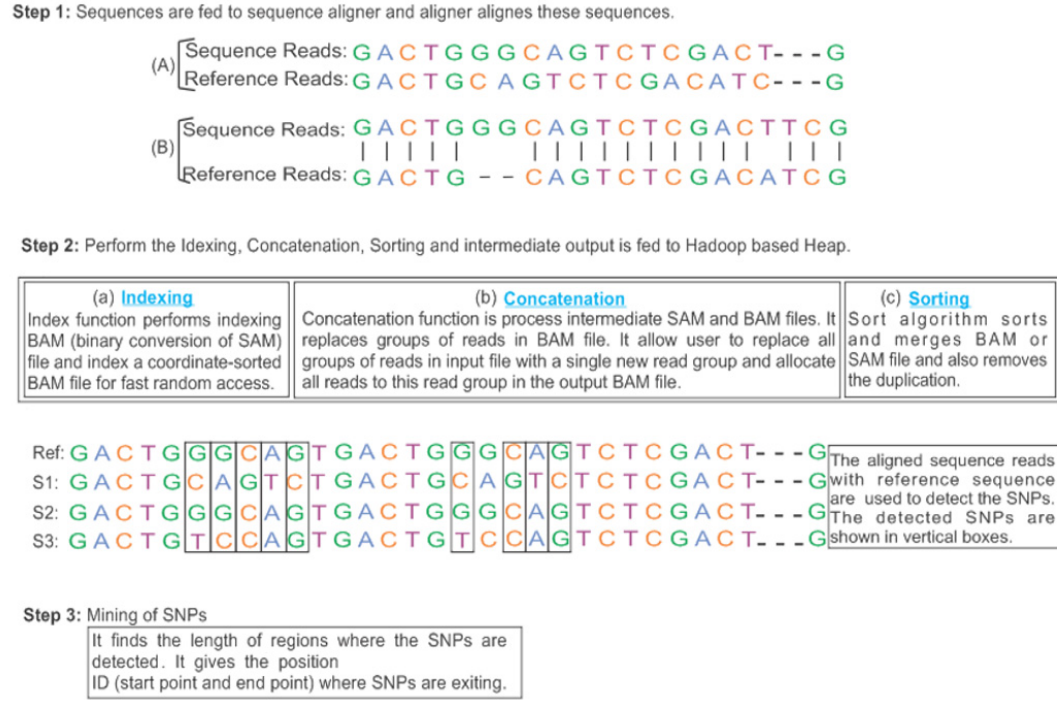
Figure 2. The stepwise procedure of proposed workflow i.e., ( Step 1 ): sequences are aligned using the Bowtie aligner version 2. ( Step 2 ): Indexing, Concatenation, and Sorting operations are performed then SNP caller is used to detecting SNPs in target sequences in comparison of a reference sequence. ( Step 3 ): The mining of detected SNPs is performed to find out the regions where SNPs exist.